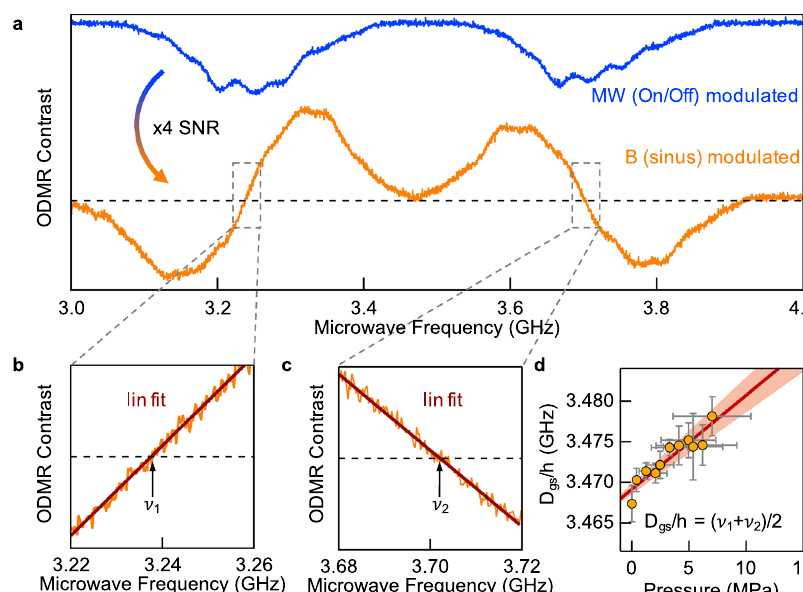
with microwave modulation (on/off) (blue) and Fig. 4 Pressure dependence of the zero- fi eld splitting parameter D gs / h . a ODMR spectra of V (cid:1) B sinusoidal magnetic fi eld modulation (orange). The partially resolved hyper fi ne peaks are blurred due to an intentional overmodulation of the spectrum (for details see Supplementary Fig. 4) that allows a linear fi t in the vicinity of the zero-crossings for a precise determination of the resonant transitions ν 1 ( b ) and ν 2 ( c ) and therefore the parameter D gs = h . d D gs = h as a function of pressure, follows a slope of (1.16 ± 0.15) Hz = Pa which is close to the expected value (0.91 ± 0.20) Hz = Pa according to Eq. (15). Vertical error bars represent the standard deviations of the linear fi ts for ν 1 and ν 2 in panels ( b , c ). Horizontal error bars indicate the uncertainty of the determination of the sample area to which the pressure is